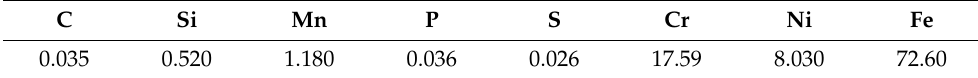
Table 2. Chemical composition of 304 stainless steel (in mass fraction/%).